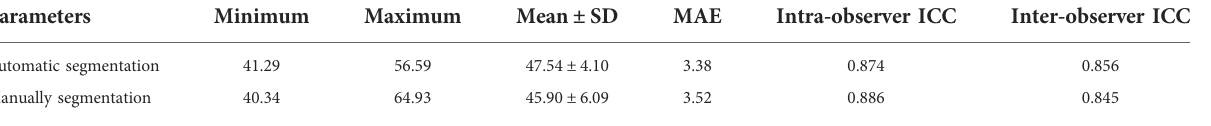
TABLE 6 The measurement results of FHD (mm) and reliability